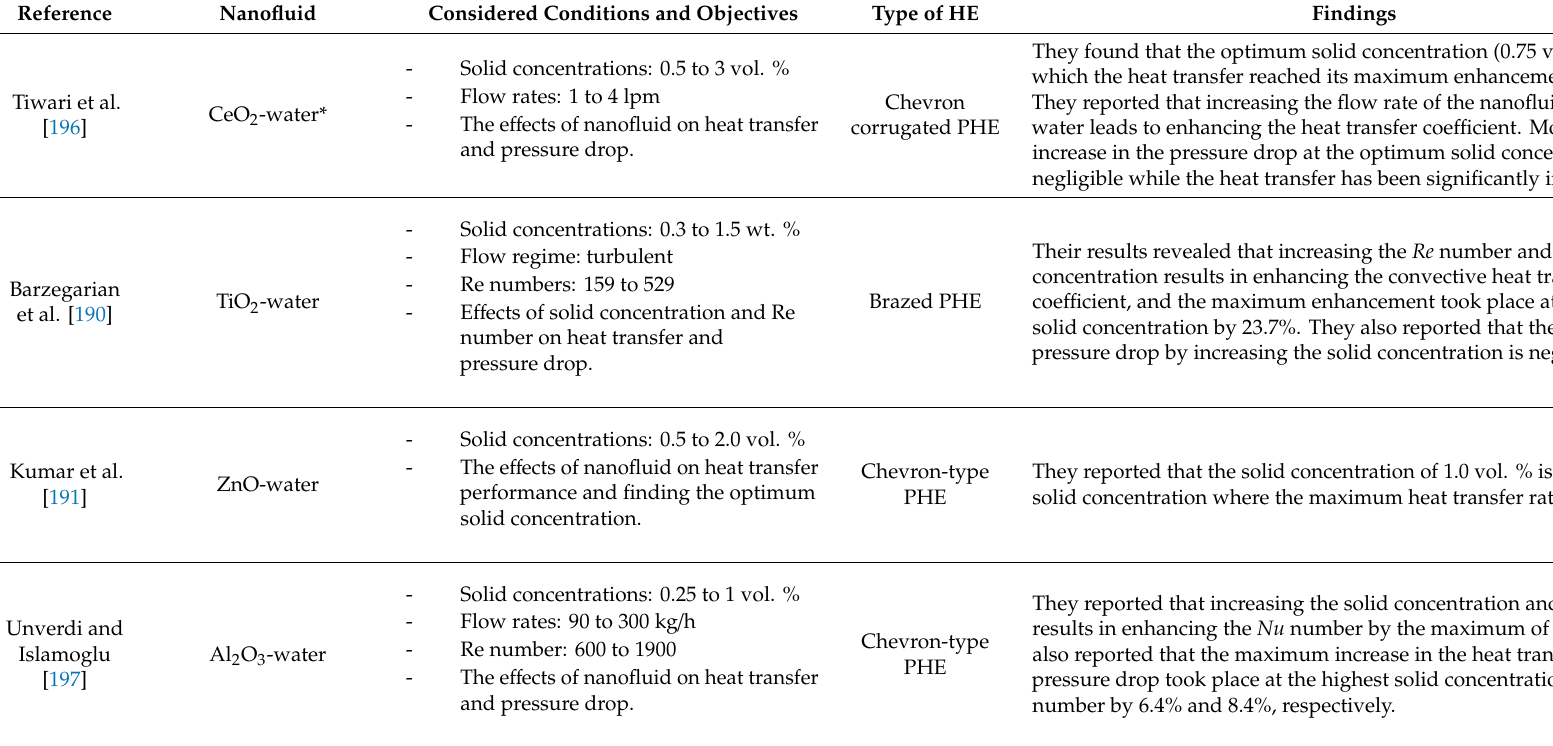
Table 2. A summary of the recently published literature on the e ff ects of using nanofluids on heat transfer performance and pressure drop of